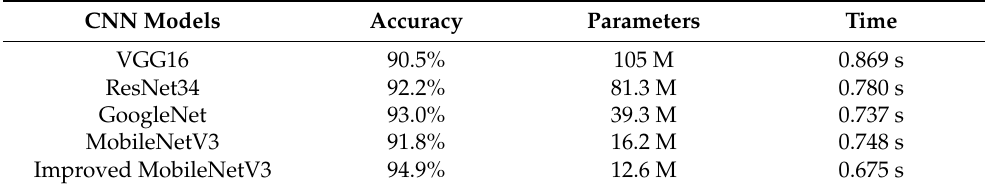
Table 3. The testing results of the CNN